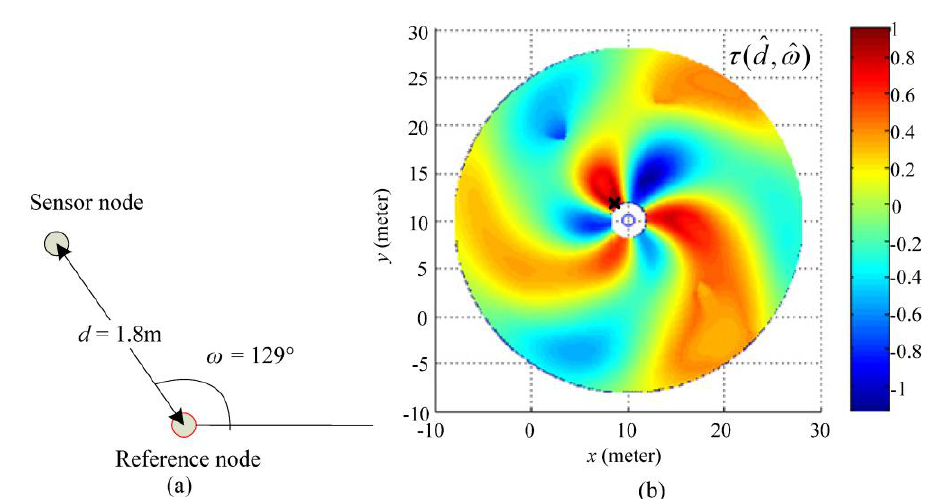
Figure 13. Experimental result for single reference node scenario. (a) Deployment arrangement of the sensor node and reference node in the scenario for single reference node. (b) Estimation result using the proposed robust correlation. The estimated coordinate of the sensor node is annotated by black cross ( ×